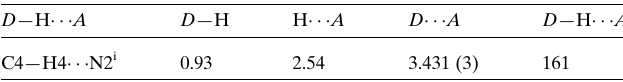
Table 1 Hydrogen-bond geometry (A˚ , (cid:2) ).